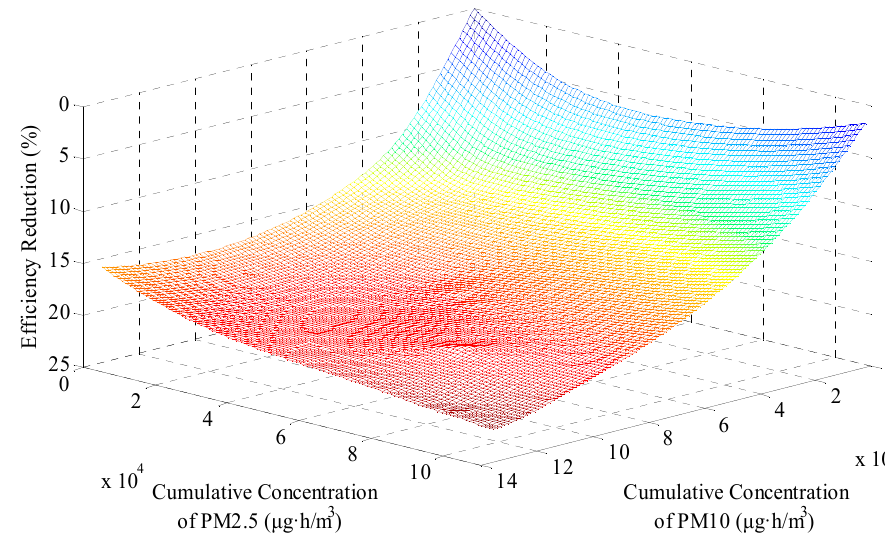
Figure 10. Sample set for PV panels with tilt angle β = 0°.